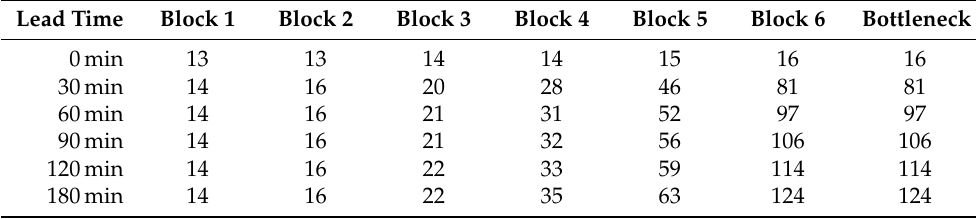
Table 3. Detailed number of channels in the network, depending on the lead time. Lead